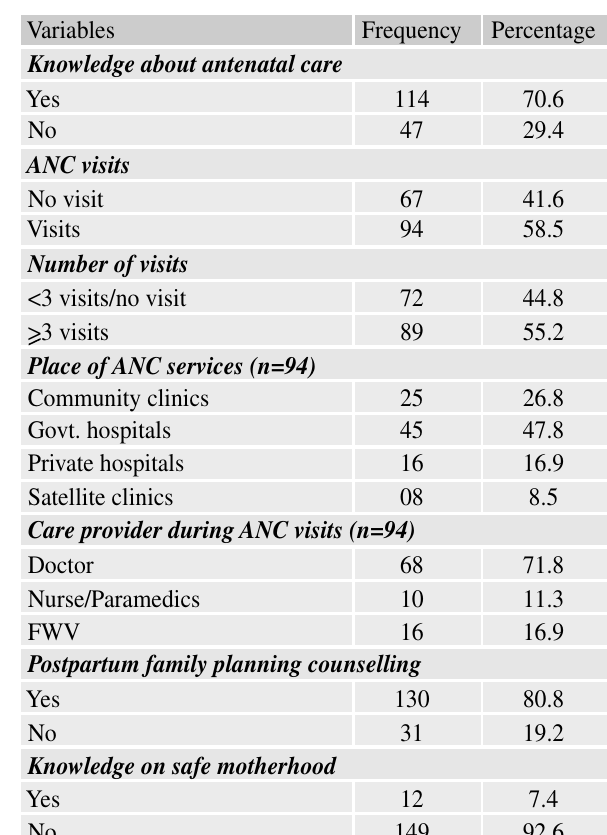
Table I: Distribution of antenatal care